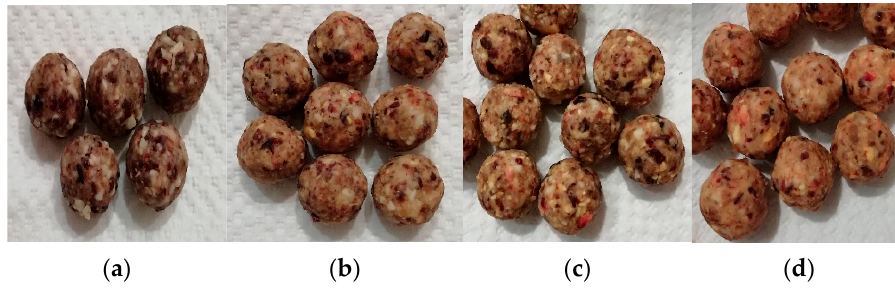
Figure 1. Bonbon formulations: ( a ) control sample; ( b ) LPP10; ( c ) LPP20; ( d ) LPP30.